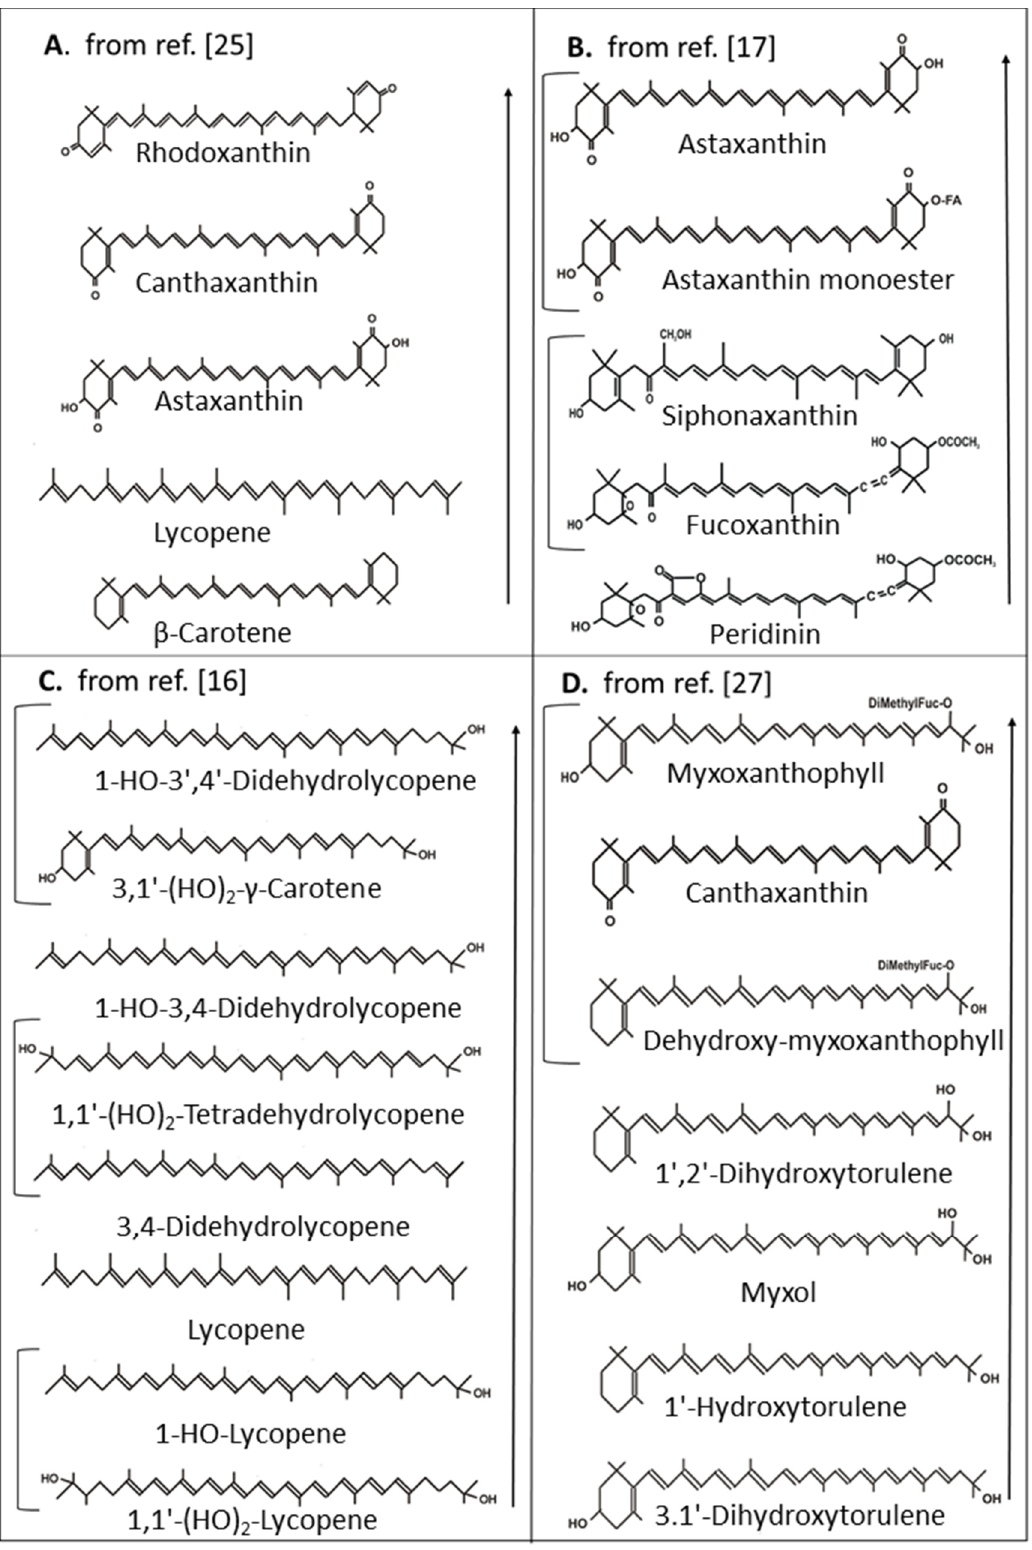
Figure 3. Comparison of 1 O 2 quenching activities of different carotenoids. Arrows indicate increasing activity, brackets indicate similar activity.